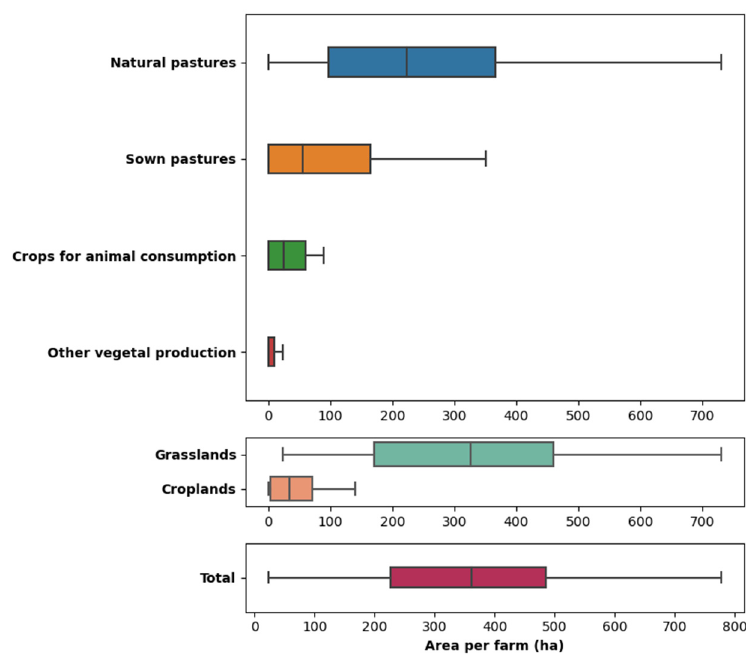
Figure 2. Areas in the sample for each land use class, ecosystem type (grassland and cropland), and total area per farm. “Grassland” area is the sum of “Natural pastures” and “Sown pastures”, and “Croplands” is the sum of “Crops for animal consumption” and “Other vegetal production”.